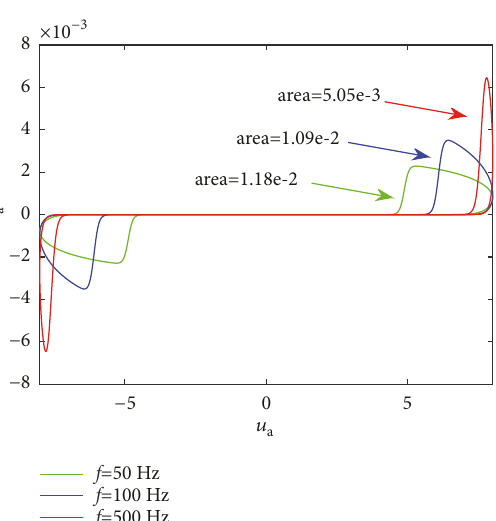
Figure 12: Input current of a phase versus time t .